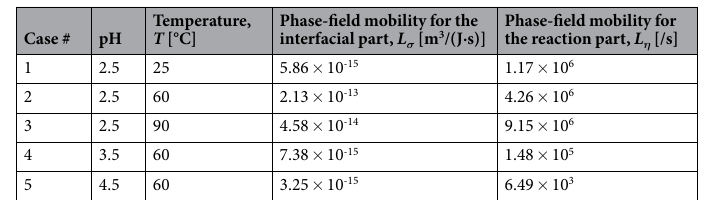
Table 3. Phase-field mobilities for the interfacial part and reaction part in each